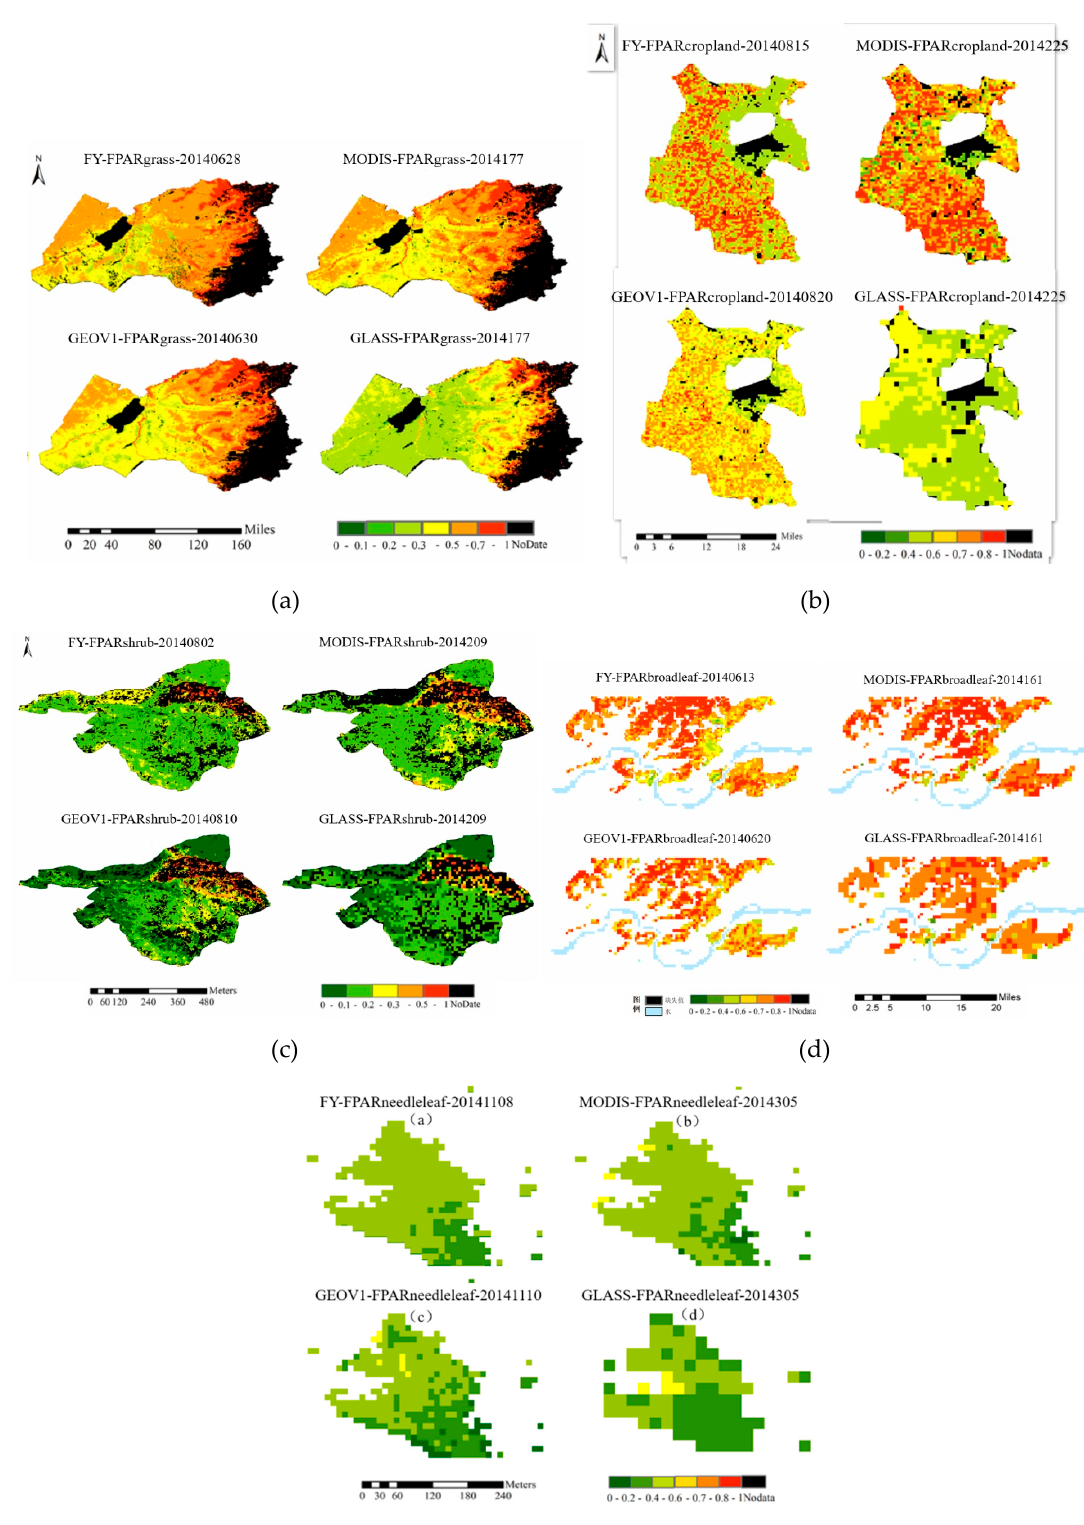
Figure 5. The spatial distribution of the result of FPAR inversion and FPAR products; ( a ), ( b ), ( c ), ( d ), and ( e ) are grassland, cropland, shrub, broadleaf forest, and needleleaf forest, respectively.